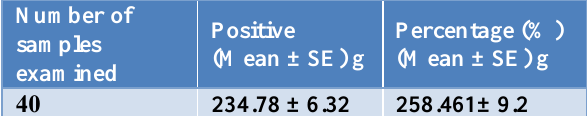
Table, 3: Effect of Eimeria spp infection on body weight of Columbidae pigeon.